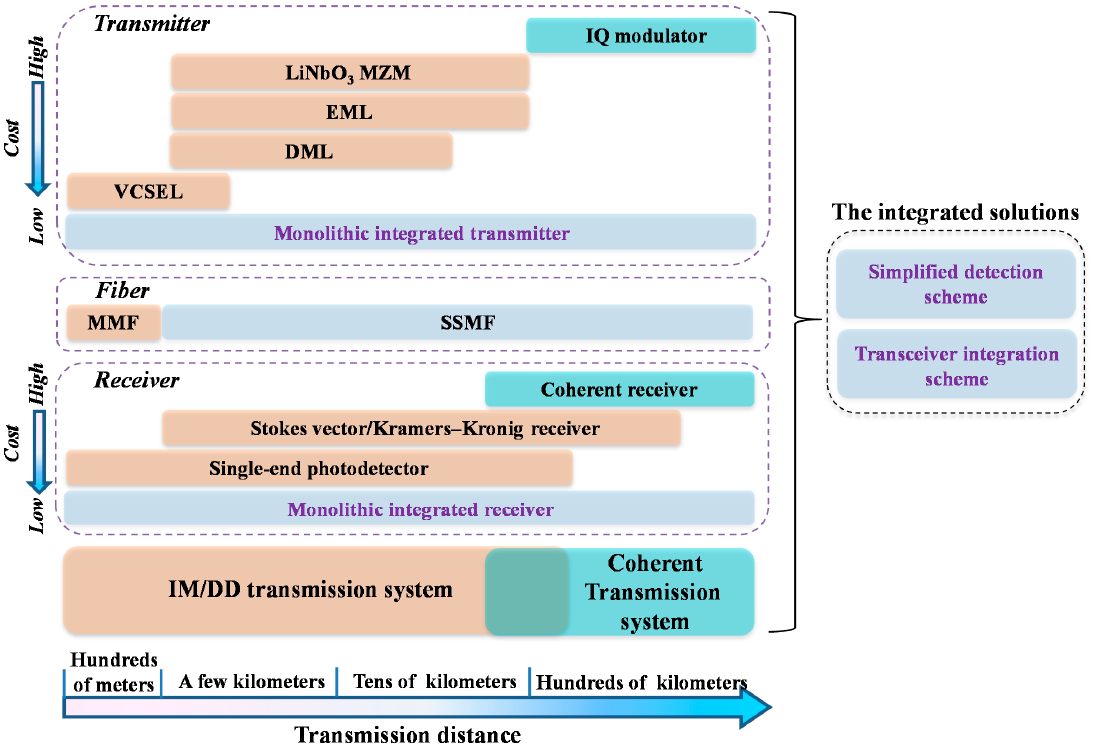
Figure 16. The technological and component options for high-speed short-reach transmission systems.